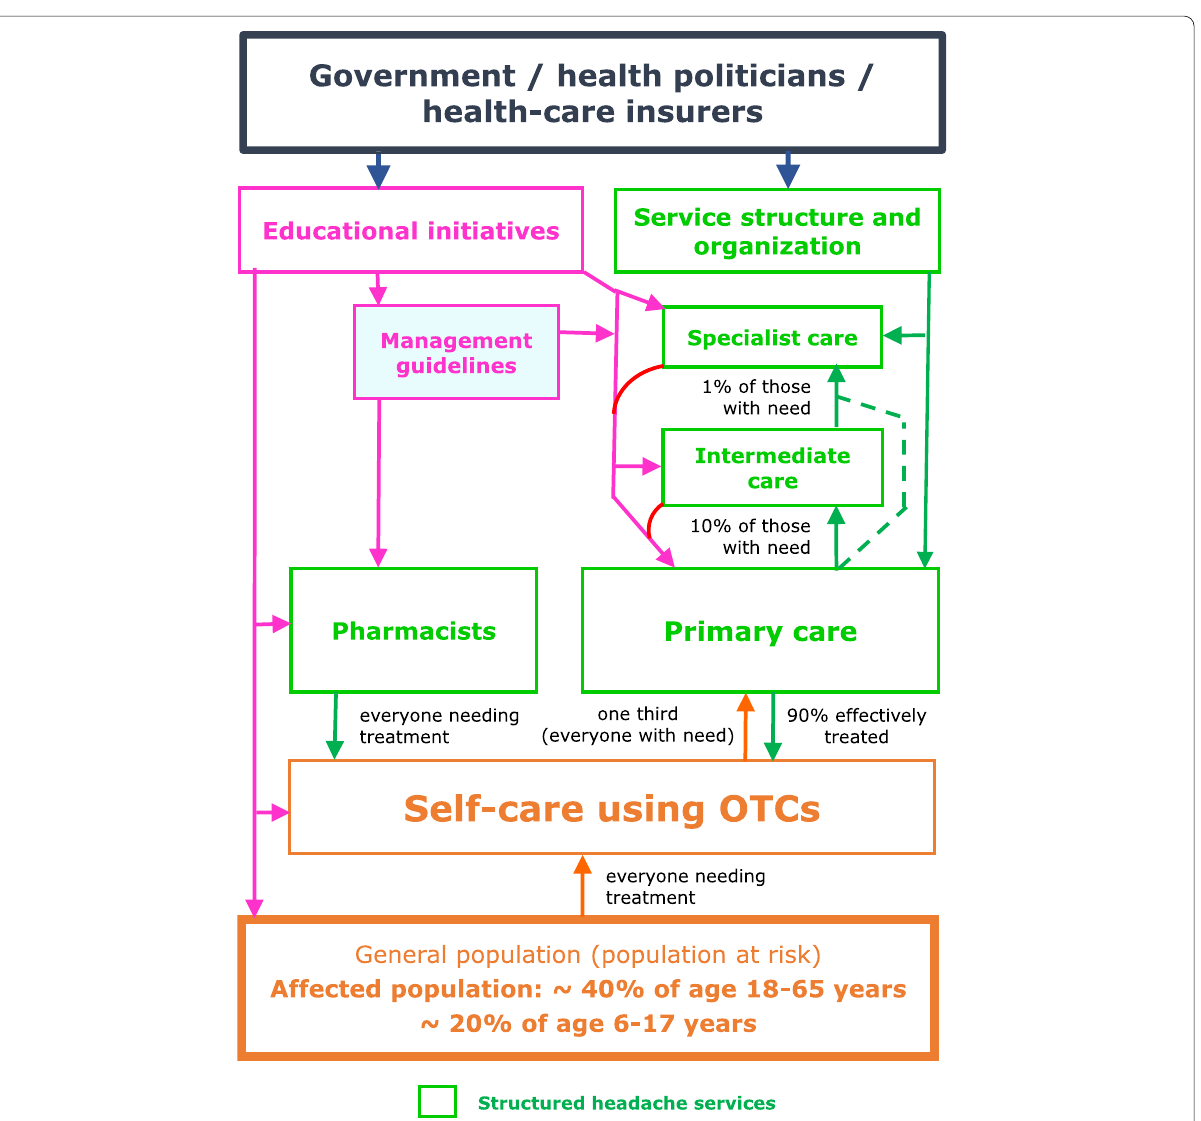
Fig. 1 Adaptable template for structured headache services based in primary care and supported by educational initiatives and management aids, with expected patient flows (from